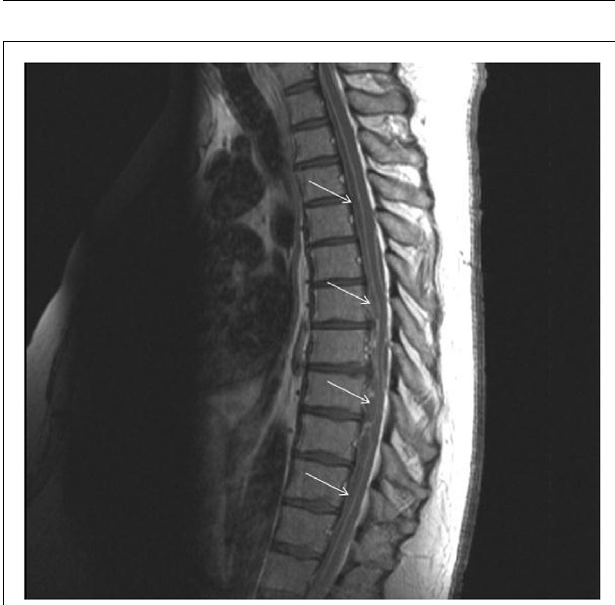
FIGURE 4 | SagittalT1 post-contrast image of thoracic spine demonstrates loculated fluid collection in subdural space (arrows) with mass effect on the cord.